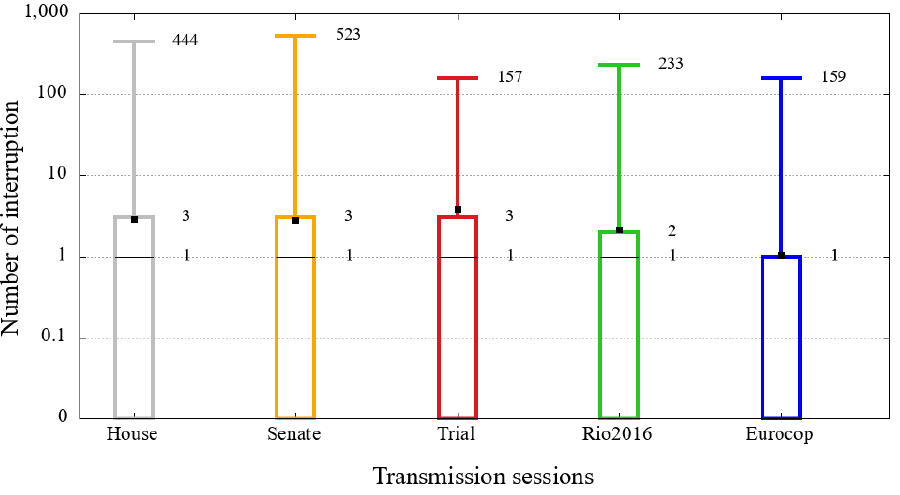
Figure 19. Distribution of the number of interruptions in the broadcasting session of the opening of the Rio 2016 Olympics, the Eurocup 2016 semi-final between Portugal and Wales and the House of representatives, Senate and Judgment Impeachment